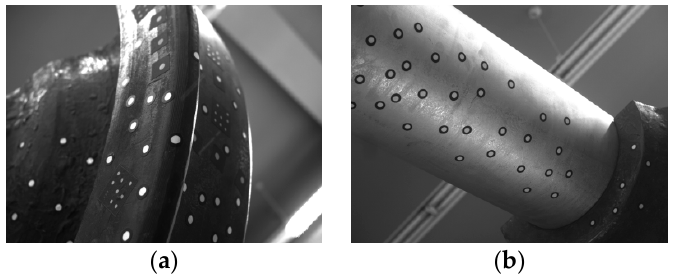
Figure 4. The images for the global calibration. ( a ) The target image of the camera for the wheel tread measurement; ( b ) the target image of the camera for the wheelset axle measurement.